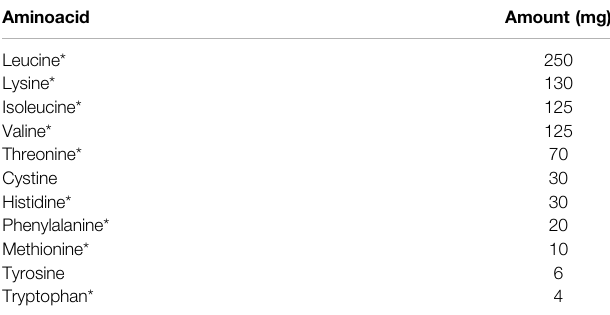
TABLE 1 | L-aminoacid content per tablet (* denotes an essential